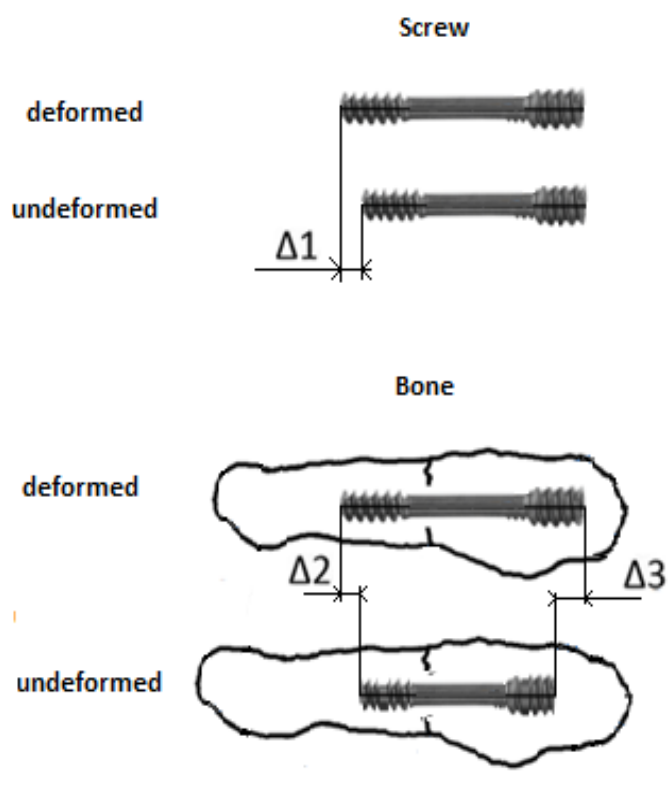
Figure 7. Explanation of displacements ∆ 1, ∆ 2, and ∆ 3 (not in real